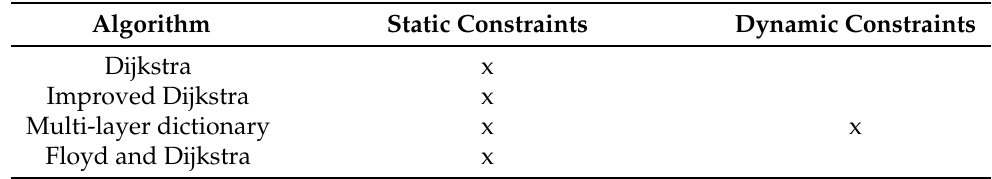
Table 1. Suitability of the Dijkstra algorithm and its variants as classified based upon static and dynamic environmental